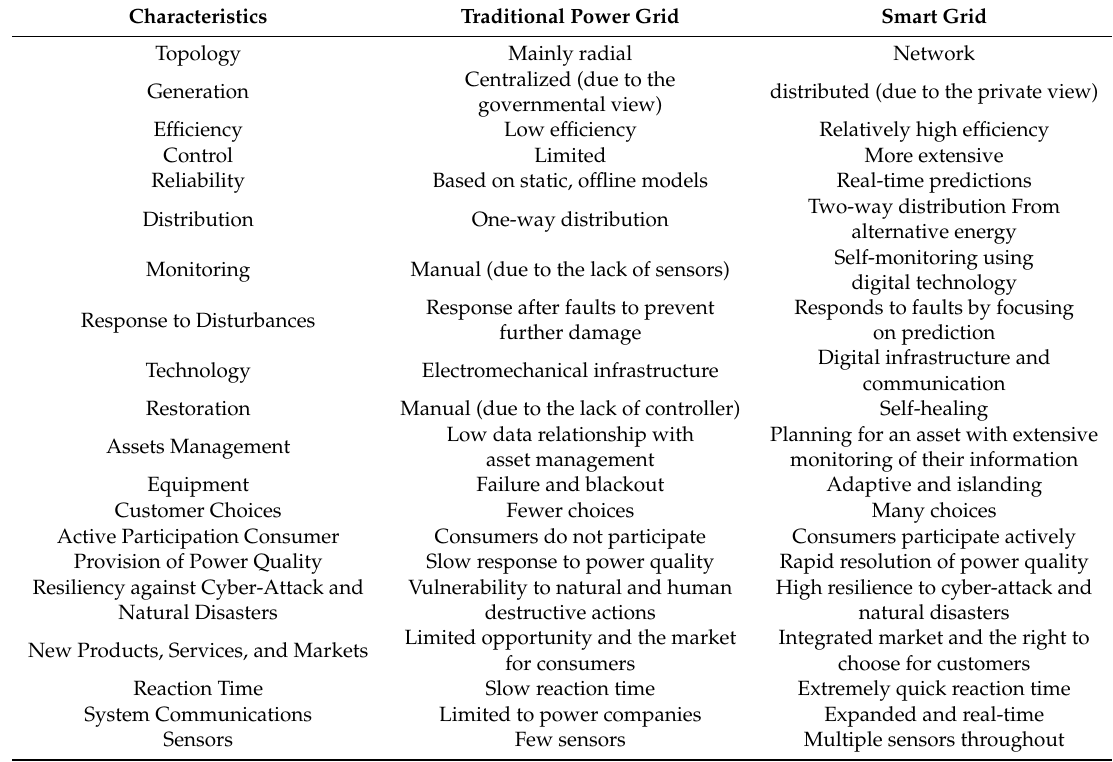
Table 4. Comparison of traditional power grids and smart